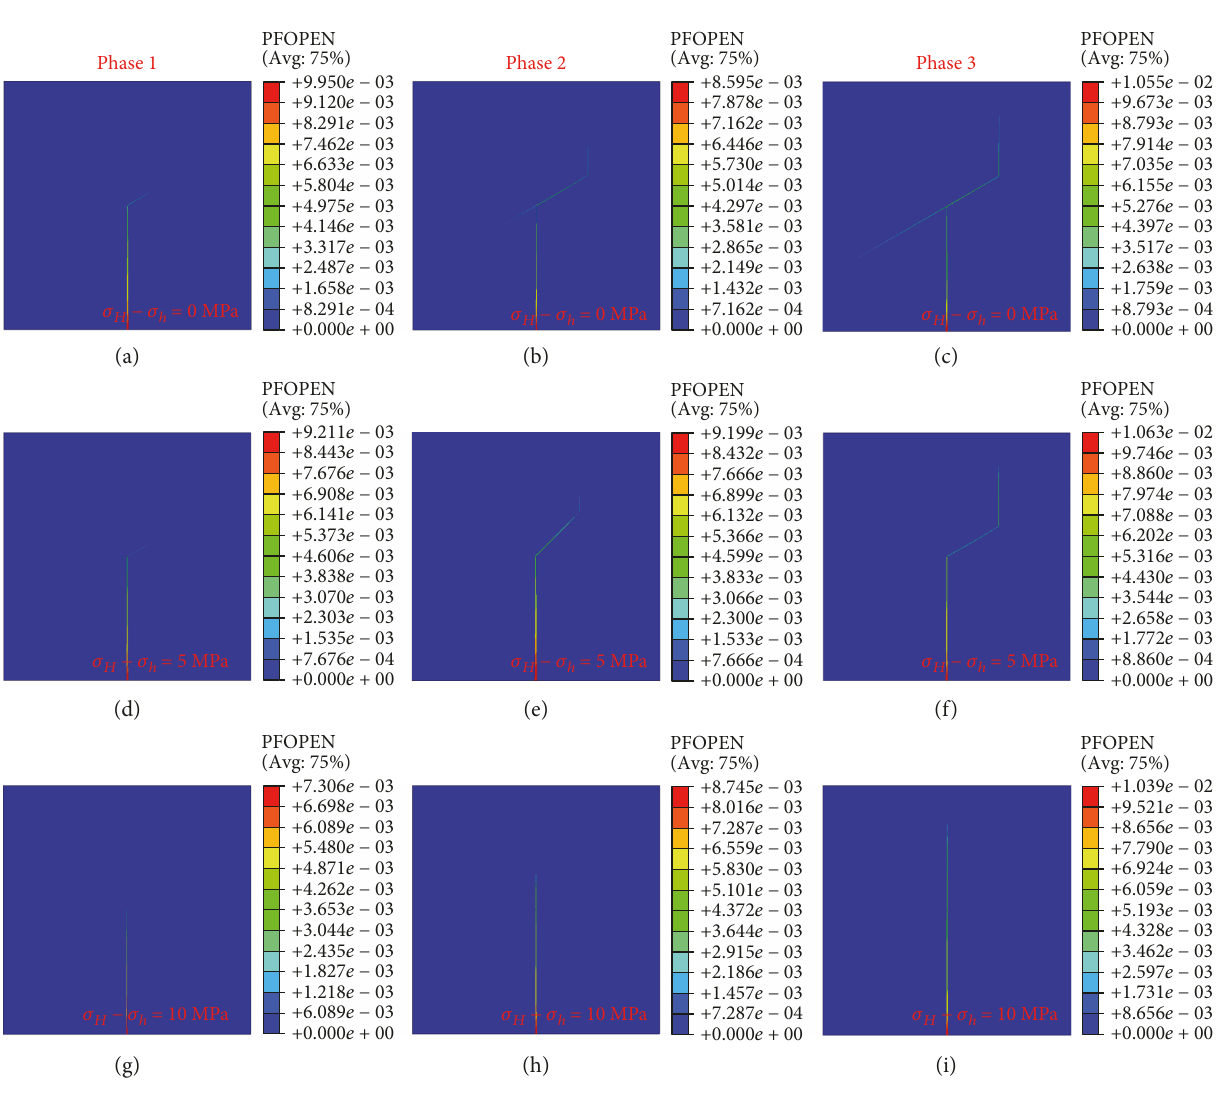
Figure 9: Approaching angle of 60 °